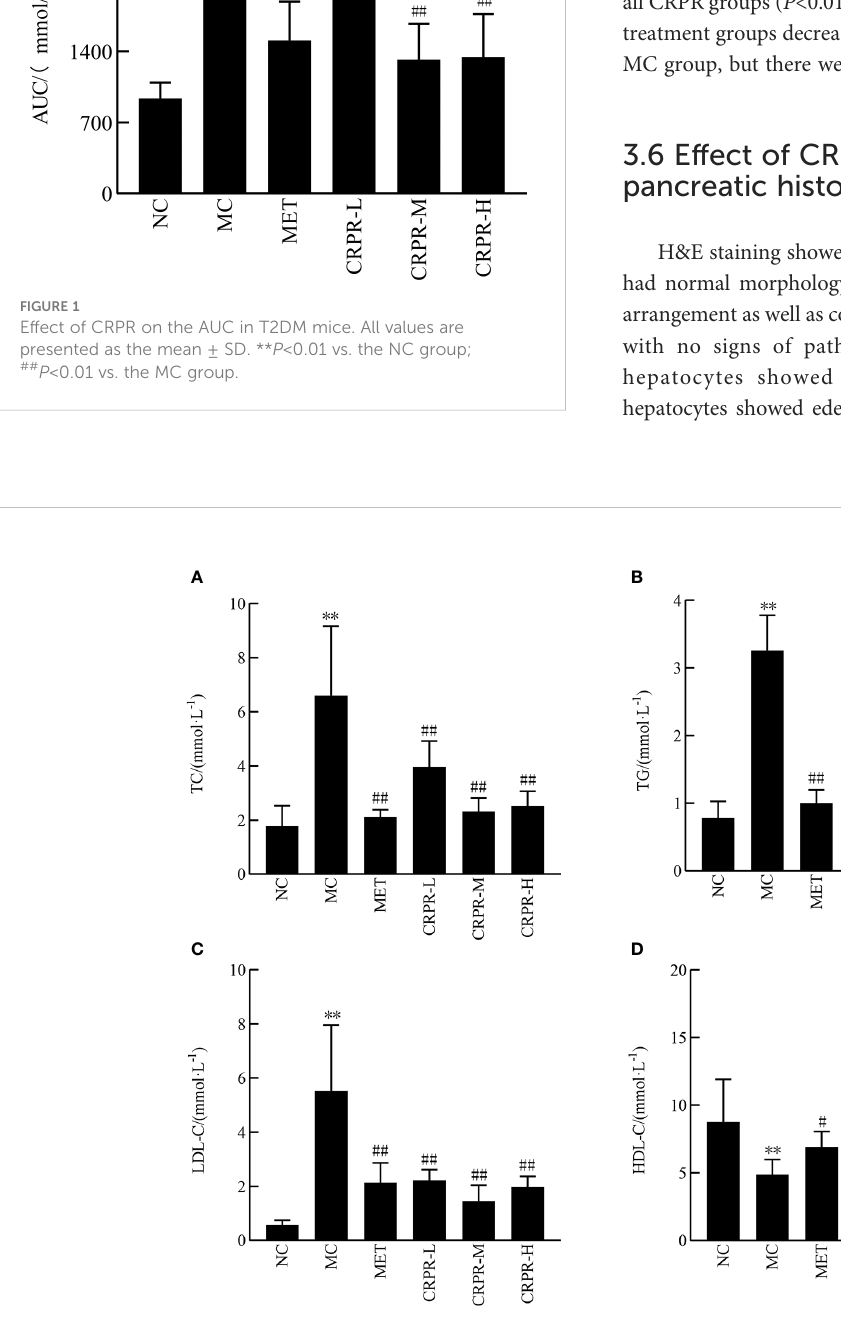
FIGURE 2 Effect of CRPR on blood lipids in T2DM mice. (A) Effect of CRPR on TC. (B) Effect of CRPR on TG. (C) Effect of CRPR on LDL-C. (D) Effect of CRPR on HDL-C. All values are presented as the mean ± SD. ** P <0.01 vs. the NC group; # P <0.05 and ## P <0.01 vs. the MC group.